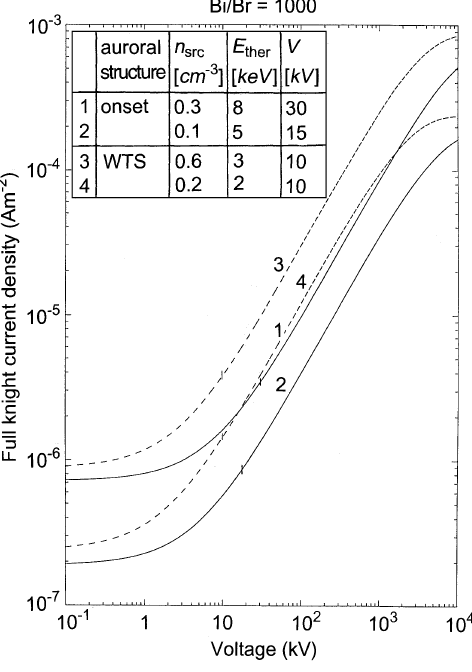
Fig. 7. Plot showing that the assumptions for a linearization of the full Knight formula is valid for the substorm-related events in this